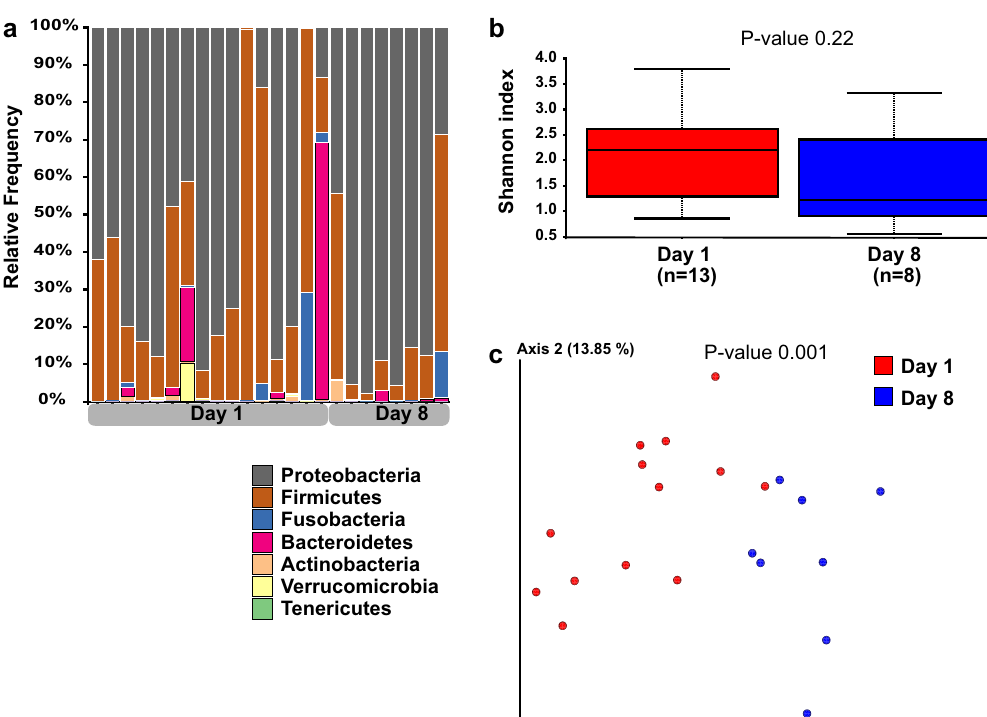
Fig. 2 Rectal bacterial composition in puppies with Fading Puppy Syndrome on Days 1 and 8 post-partum. a Taxonomy bar plot; b alpha diversity analysis using Shannon index; c principal coordinate analysis plot representing beta diversity based on Jaccard distances (permutational multivariate analysis of variance, P = 0.001).